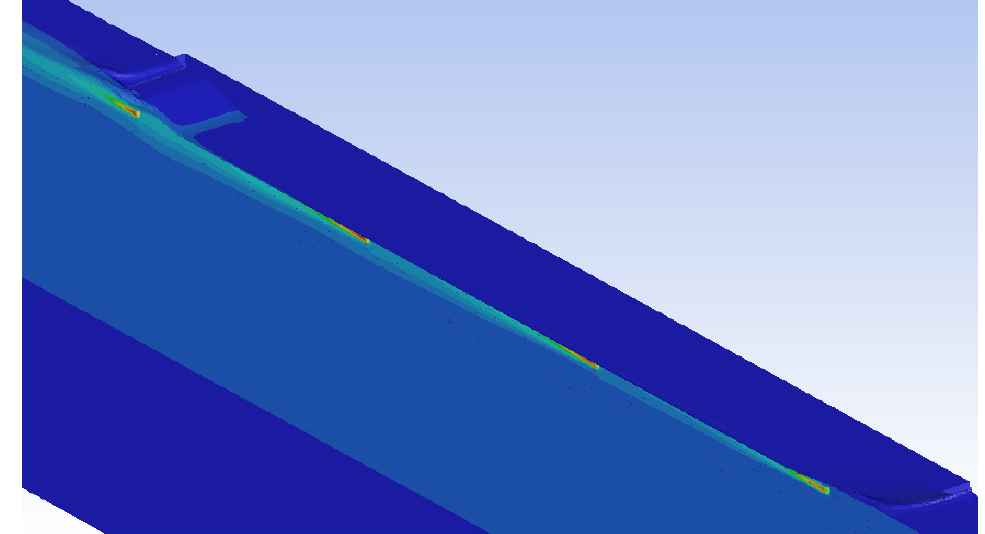
Figure 4. Velocity magnitude on the free water surface (Layout E, deep water). Source: Authors.